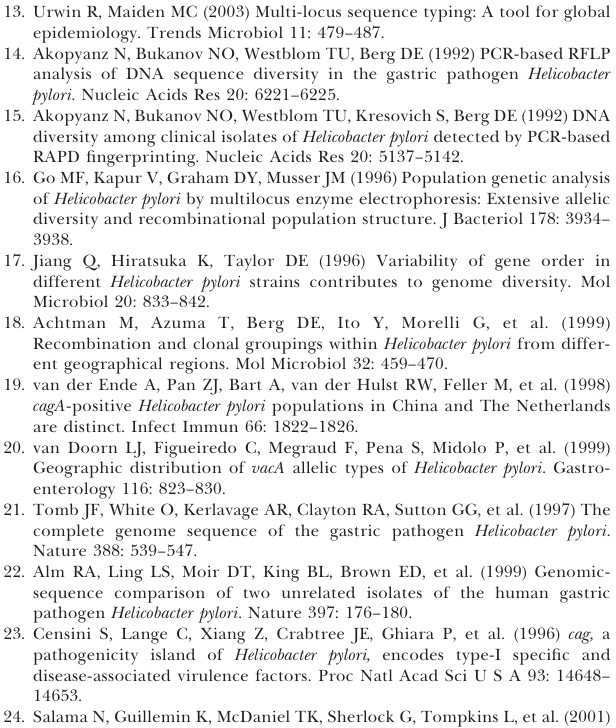
Table S1. List of PCR Products Table S2. List of PCR Products with Multiple Hits within the Genome Table S3. List of Strains Table S4. List of 499 Variable CDSs in H. pylori Table S5. List of 1,150 PCR Products that Hybridized with All H. pylori Strains Table S6. Variable CDSs in H. pylori (sub)populations Table S7. Accuracy, Sensitivity, Specificity and Predictive Value of Hybridizations with the Genomic Sequences of Sheba and 162.0 Found at DOI: 10.1371/journal.pgen.0010043.st007 (47 KB